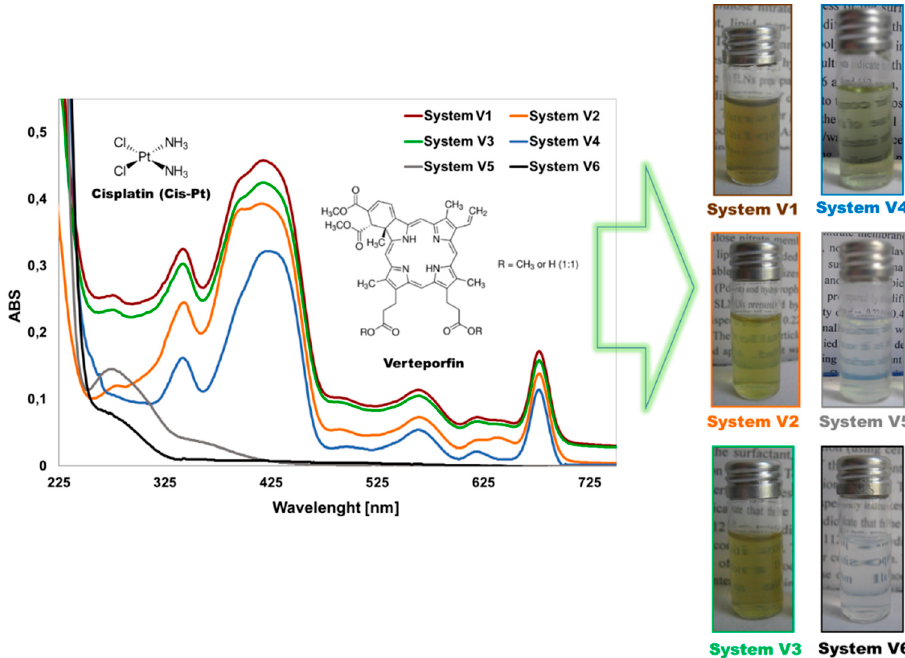
Figure 1. Ultraviolet - Visible (UV-VIS) spectra and images of the VP and CisPt co-loaded nanocarriers with various PLGA shells (samples V1–V3) compared to the control samples loaded only by the cytostatic drug (V5), only by the photosensitizer (V4), and the empty NCs (V6). See descriptions for the systems (V1–V6) in Table 1.